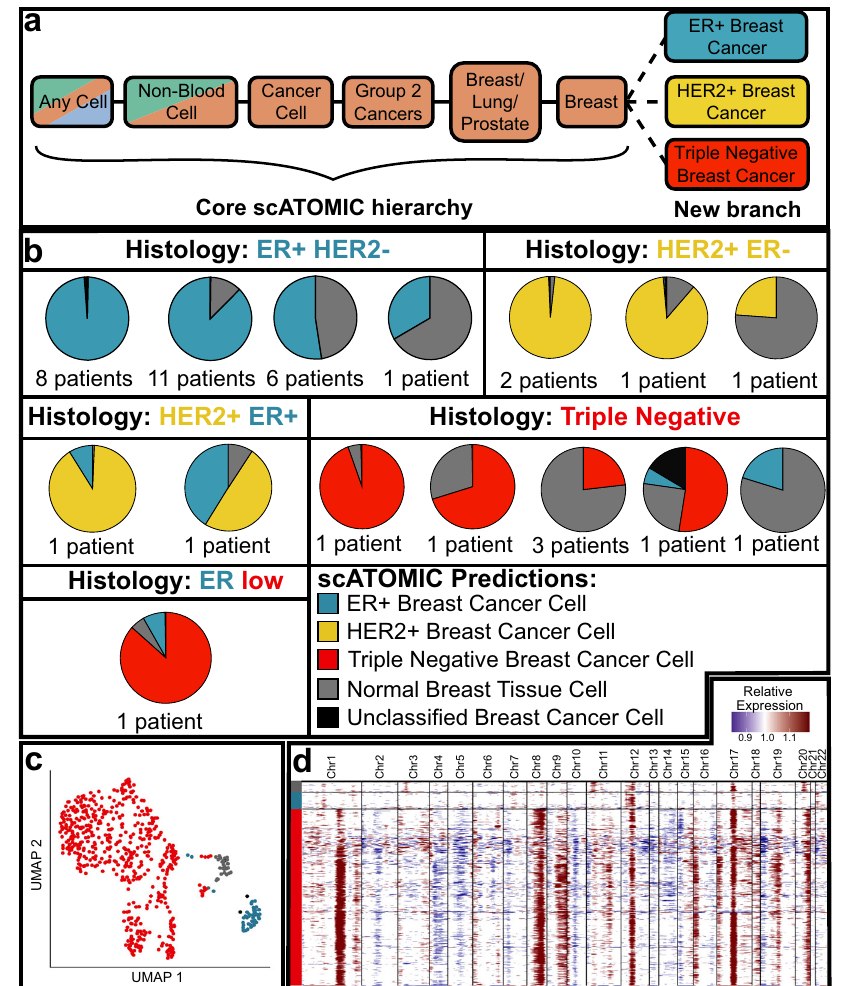
Fig. 5 | Extending the core scATOMIC model to further classify breast cancer subtypes. a The terminal breast cancer cell node from the core hierarchy of scA- TOMIC is extended to subclassify breast cancers into their major ER+, HER2+, and triple negative histological subtypes. b Validation of scATOMIC predictions in an externalcohort 44 .Piechartsre fl ectingintra-tumouralbreastsubtypeheterogeneity according to scATOMIC classi fi cation are shown for each reported histological subtype. Patient specimens with similar distributions of cell annotations are illu- stratedtogetherinasinglepiechart. c BreastcellsfromanER-lowtumour(Patient: